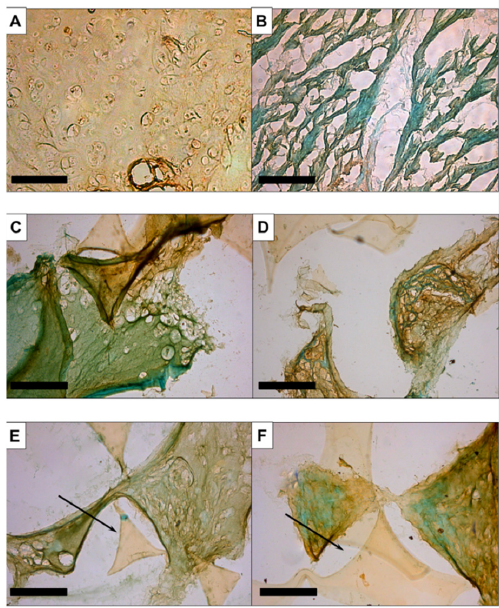
Figure 4. Immunohistochemistry with anti-aggrecan: There was clear staining in the septal cartilage ( A ) and no staining of the muscular tissue ( B ) or the constructs maintained in EM-DMEM ( C ). Brown staining was apparent in the treated groups ( D – F ). Magnification is ×200 in all figures; the scale bar represents 100 μ m.